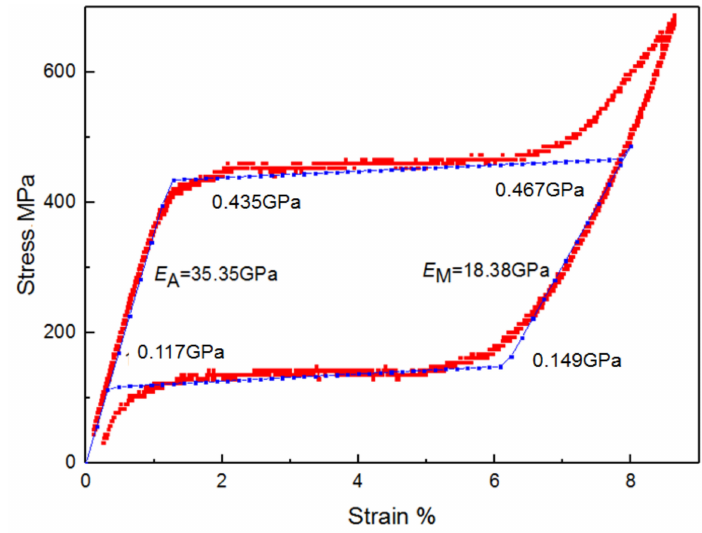
Figure 2. Stress–strain curve of a SMA wire subjected to a uniaxial loading cycle.